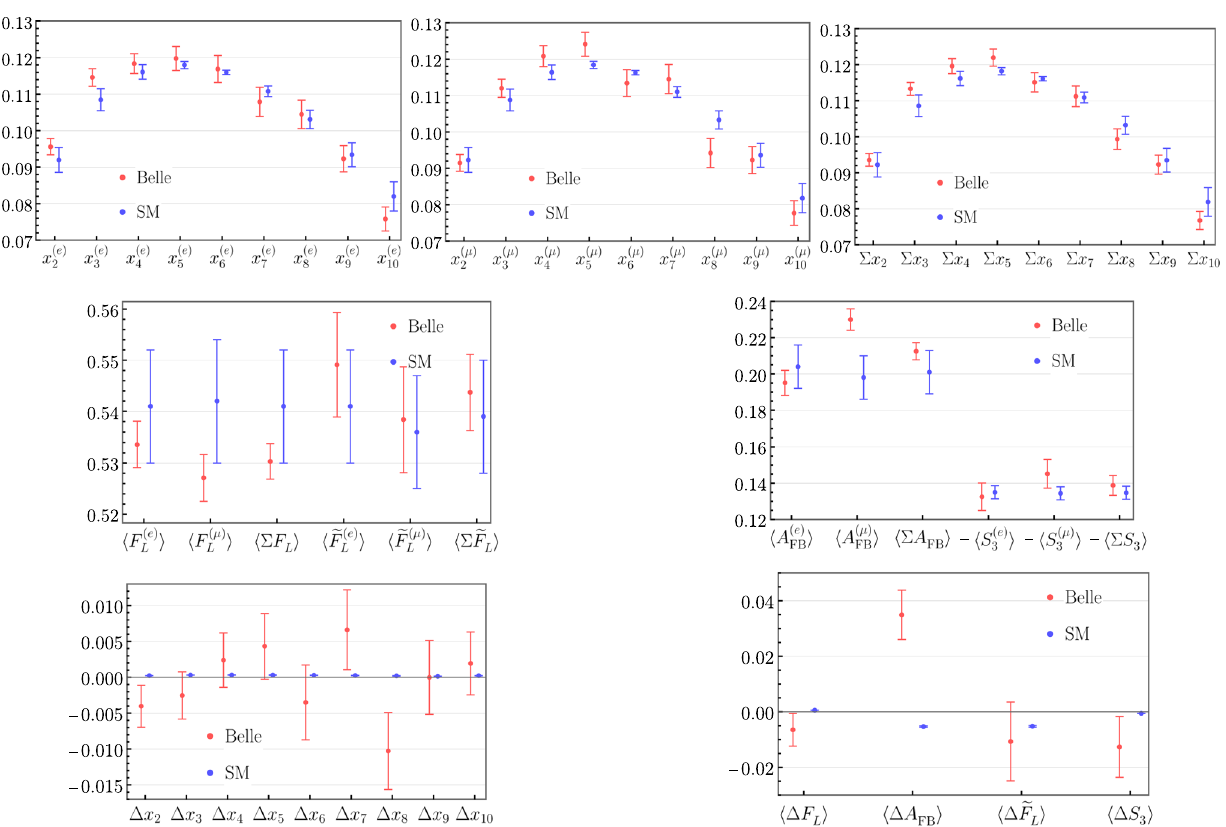
Fig. 1 The measured x ((cid:2)) from Belle versus the SM predictions for (cid:2) = e [left], (cid:2) = μ [middle] and the lepton-flavour averaged (cid:14) x i [right], and i also shown the differences (cid:15) x i [lower]. The numbers are collected in Table